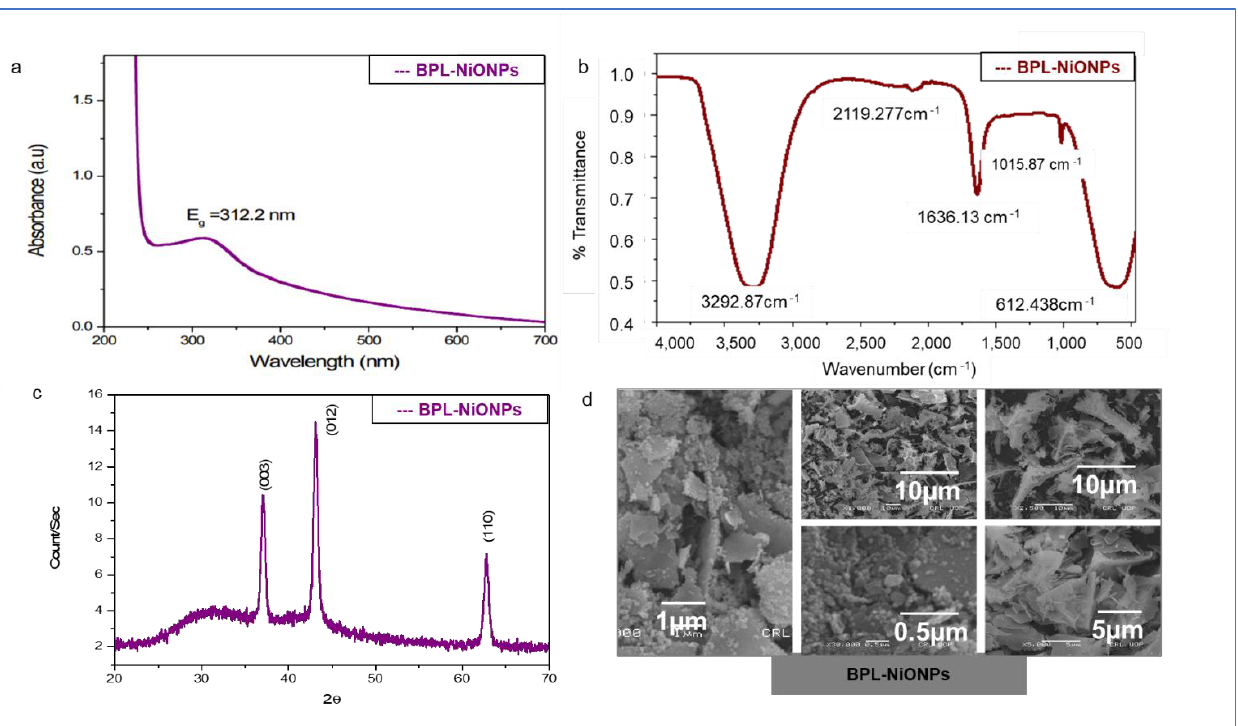
Figure 3. Zeta size distribution ( a ), zeta potential ( b ), and EDS analysis ( c ) of BPL-NiONPs. Table 2. XRD analysis of BPL based NiONPs.